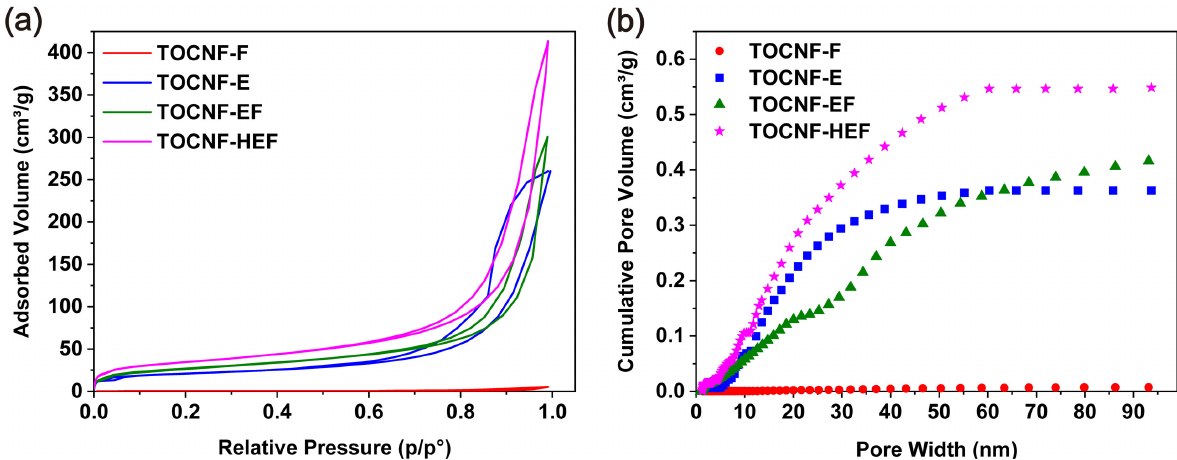
Figure 3. ( a ) Nitrogen adsorption–desorption isotherms and ( b ) cumulative pore volumes of TOCNF-F, TOCNF-E, TOCNF-EF and TOCNF-HEF separator.